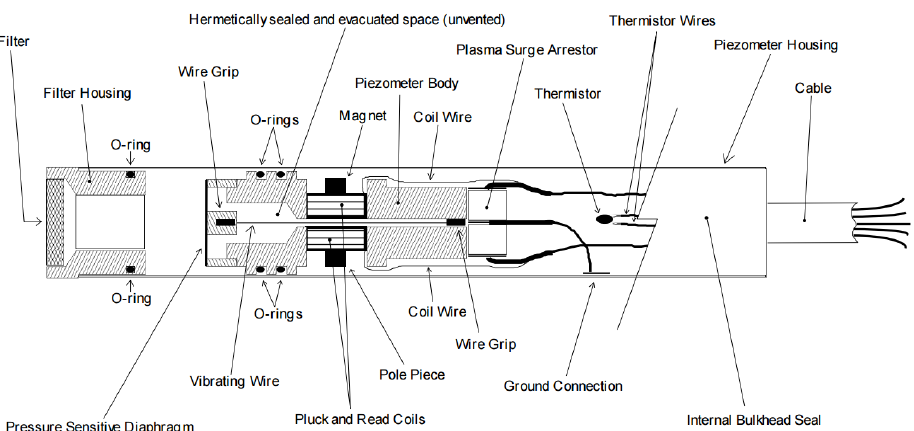
Figure 3. Physical map of vibrating string sensor GK-4500S.